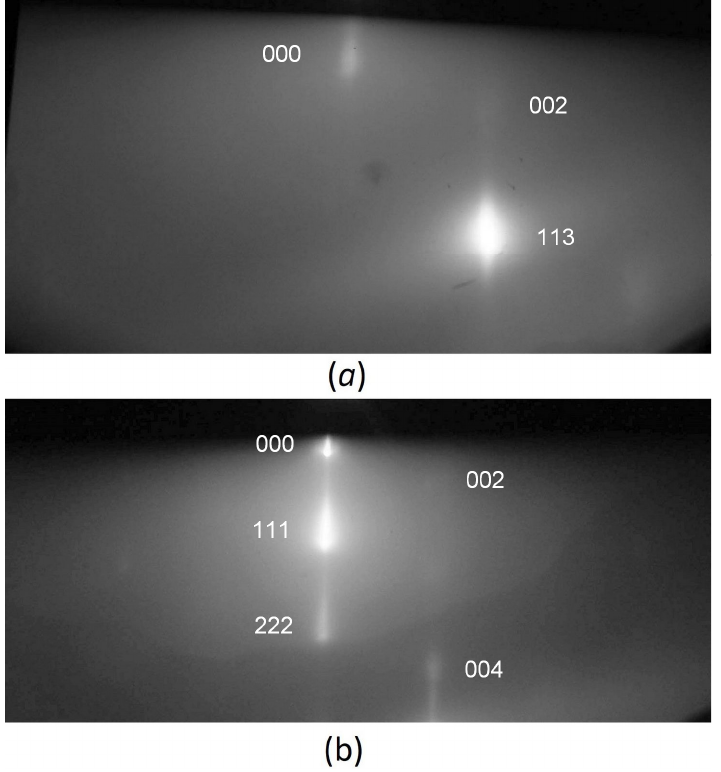
Figure 5. RHEED patterns of 3C–SiC samples containing silicon vacancies, grown on Si of n-type ( a ) and p-type ( b ).